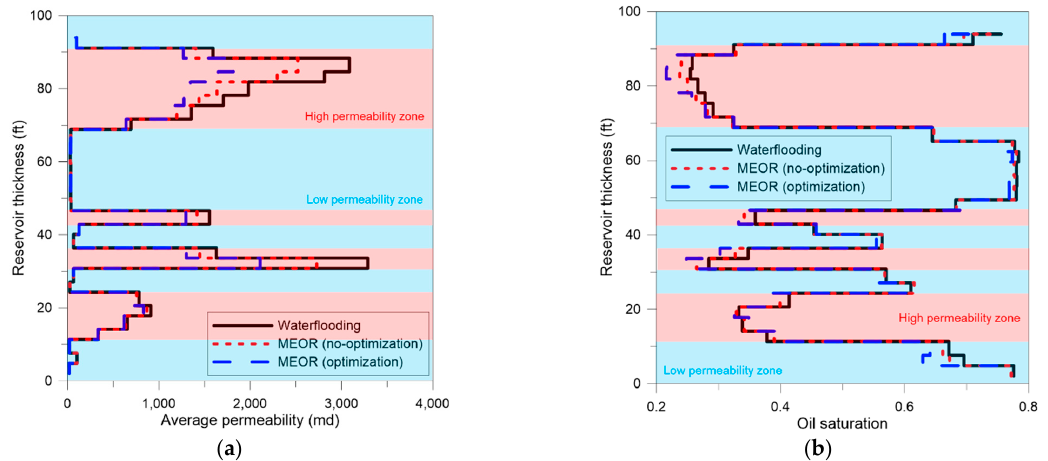
Figure 11. Distributions of ( a ) permeability and ( b ) oil saturation at the end of simulations.